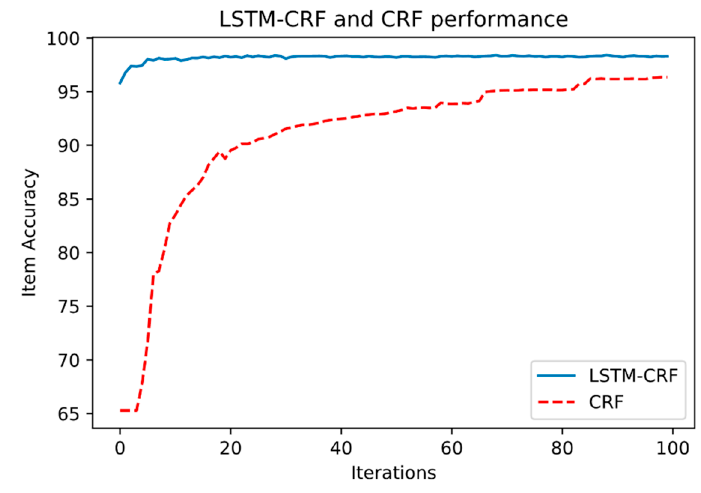
Figure 6. Item accuracy for LSRM-CRF and CRFSuite.